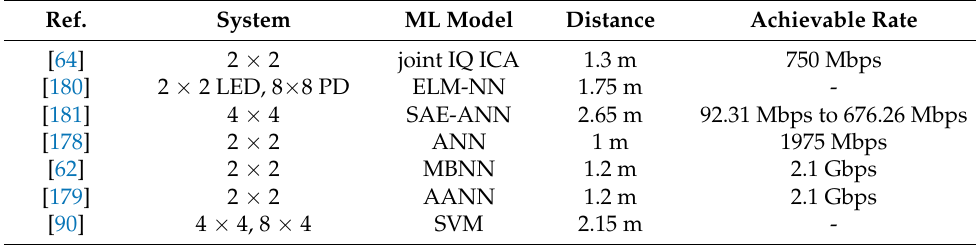
Table 4. Overview of ML based MIMO VLC